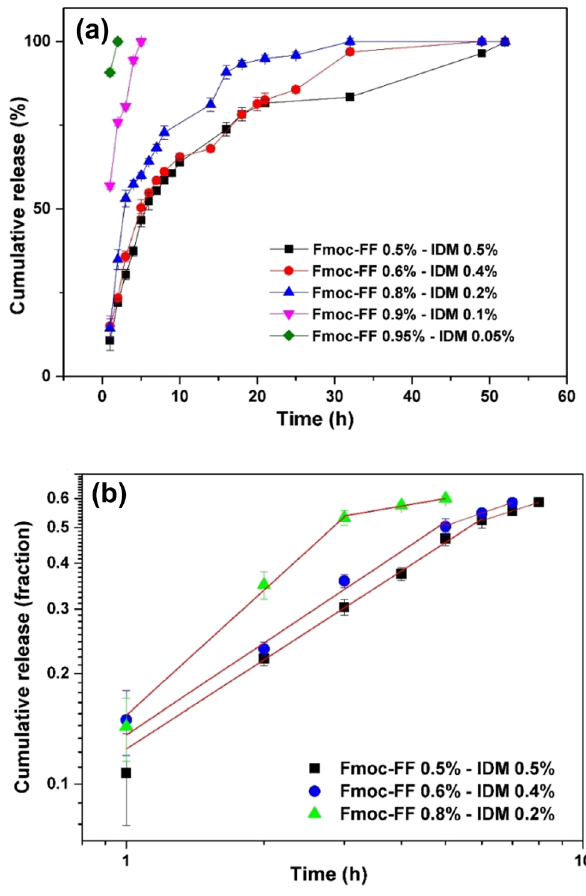
Figure 5: ( a ) In vitro cumulative release of IDM in phosphate bu ff er ( pH = 7.4 ) from Fmoc - FF – IDM hydrogels with varying Fmoc - FF/IDM ratio. ( b ) Plots of in vitro release data against release time in log – log scale and linear fi ts. The release tests were carried out in triplicate, and the results are provided as the average value ± standard